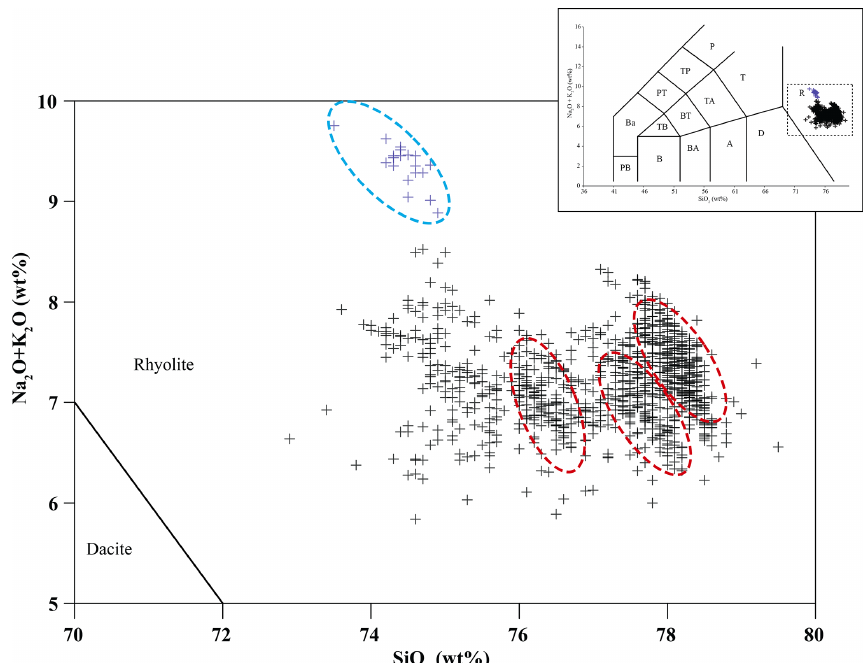
Figure 3. Total alkali (Na 2 O + K 2 O) vs. SiO 2 (TAS) plot for glass compositions for all reference data (presented on a normalised basis). Identified and highlighted by blue dashed outline are the glass-shard compositions for the Tuhua tephra (Mayor Island; MI), and highlighted by the red dashed outlines are the regions on the TAS diagram that show the highest density of samples. The inset shows a full TAS diagram (always on an anhydrous basis) to provide context for the enlarged figure. Regions of the TAS diagram follow the nomenclature of Le Maitre (1984): A – andesite, B – basalt, Ba – basanite, BA – basaltic andesite, BT – basalt–trachyte, D – dacite, P – phonolite, PB – picrobasalt,